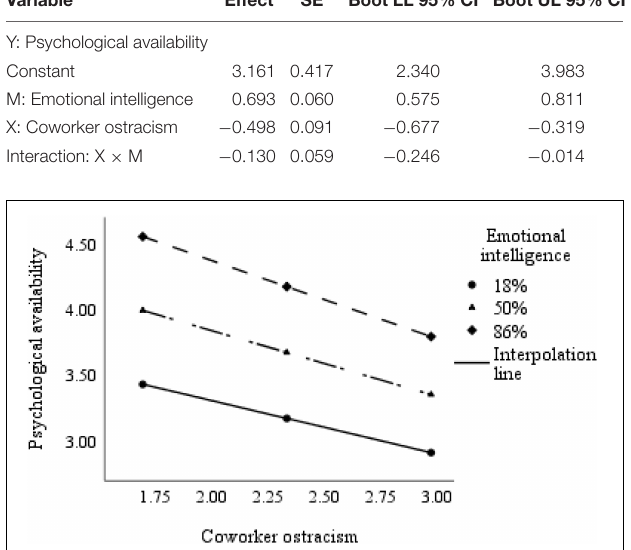
TABLE 5 | Emotional intelligence as a moderator in the relationship between coworker ostracism and psychological availability of newcomers. Variable